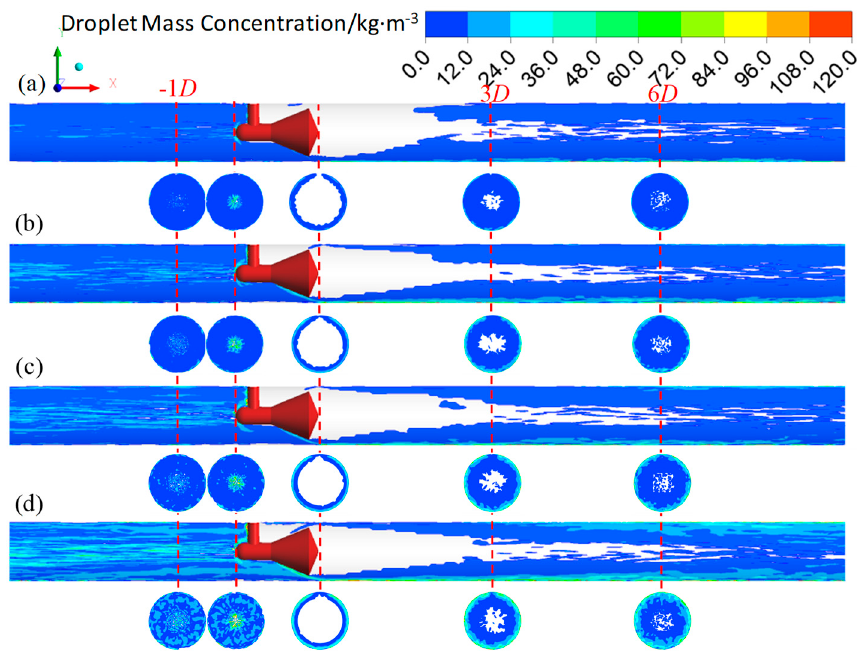
Figure 17. Droplet mass concentration under different liquid velocity. ( a ) U sg = 21.3 m·s − 1 , U sl = 0.13 m·s − 1 ; ( b ) U sg = 21.4 m·s − 1 , U sl = 0.21 m·s − 1 ; ( c ) U sg = 20.6 m·s − 1 , U sl = 0.26 m·s − 1 ; ( d ) U sg = 20.9 m·s − 1 , U sl = 0.38 m·s − 1 .